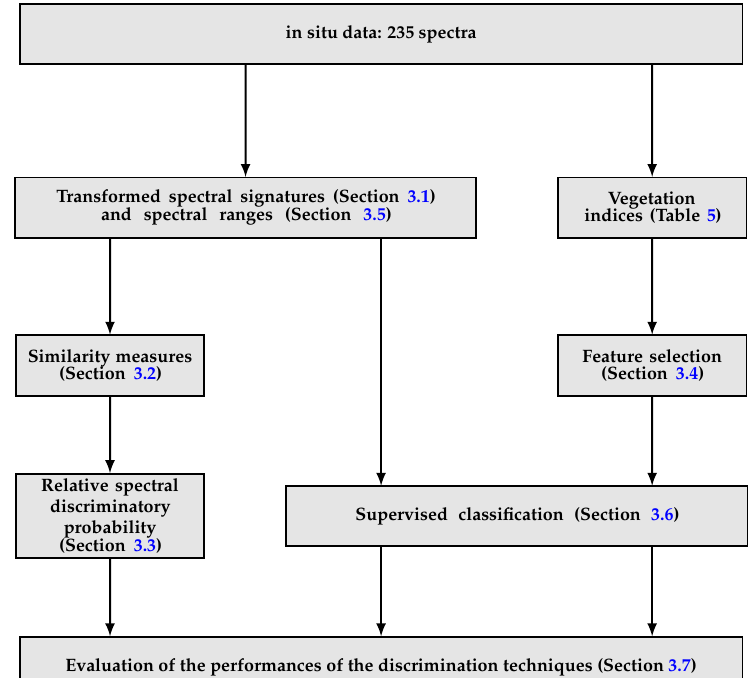
Figure 3. Flowchart showing the different methods used to classify the vegetation